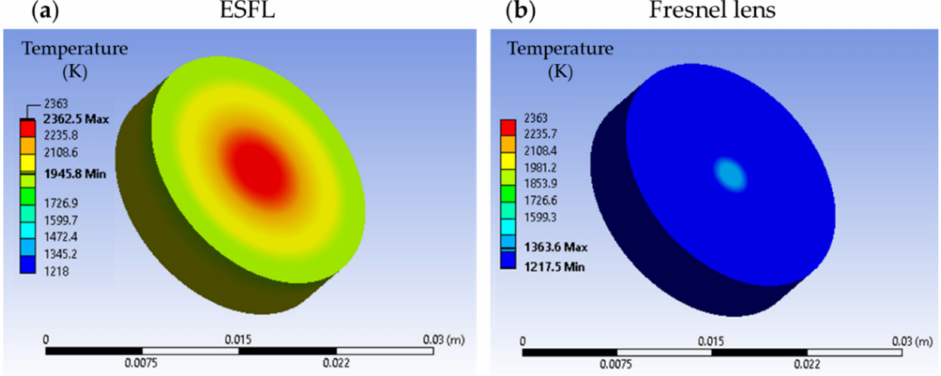
Figure 19. Focal temperature of ESFL ( a ) and flat Fresnel lens ( b